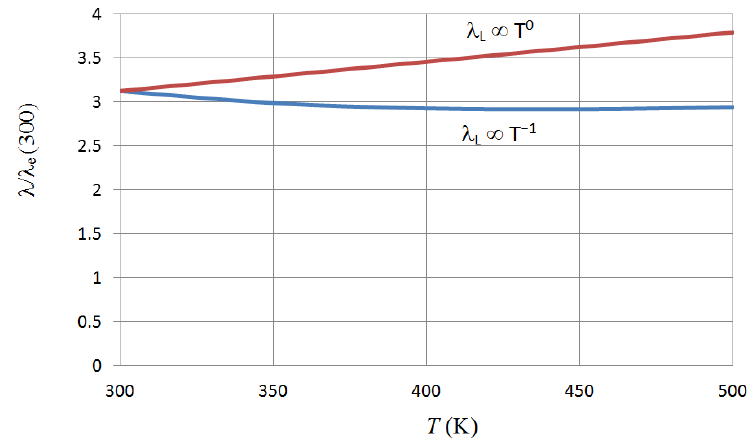
inversely proportional to temperature (lower plot). L